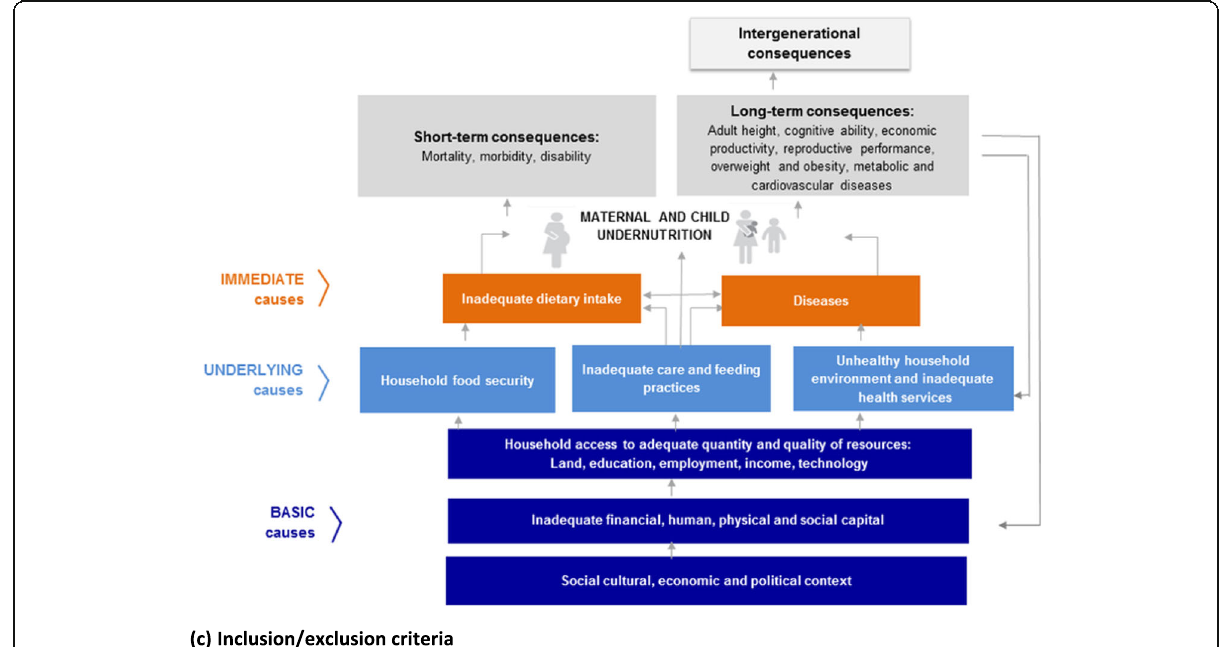
Fig. 2 UNICEF conceptual framework for causes of malnutrition (UNICEF